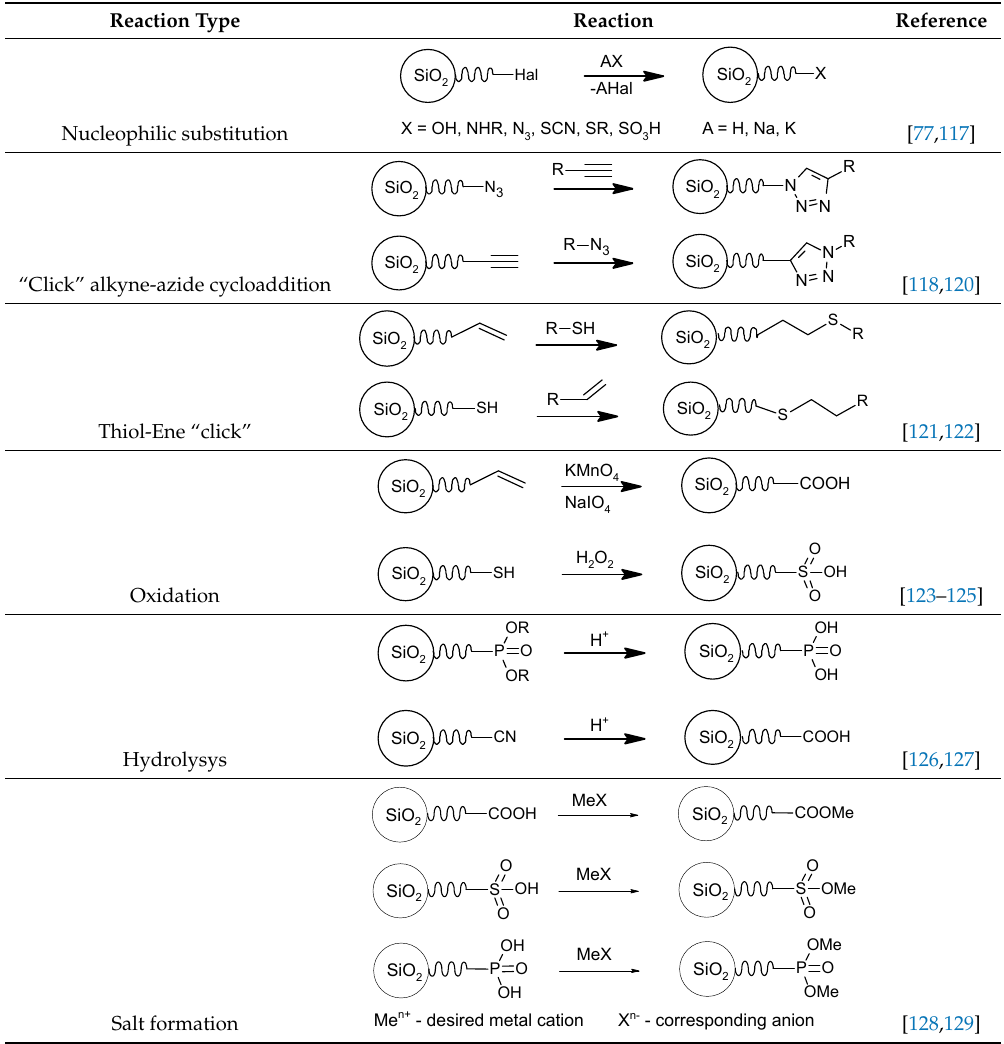
Table 3. Selected reactions on different functional